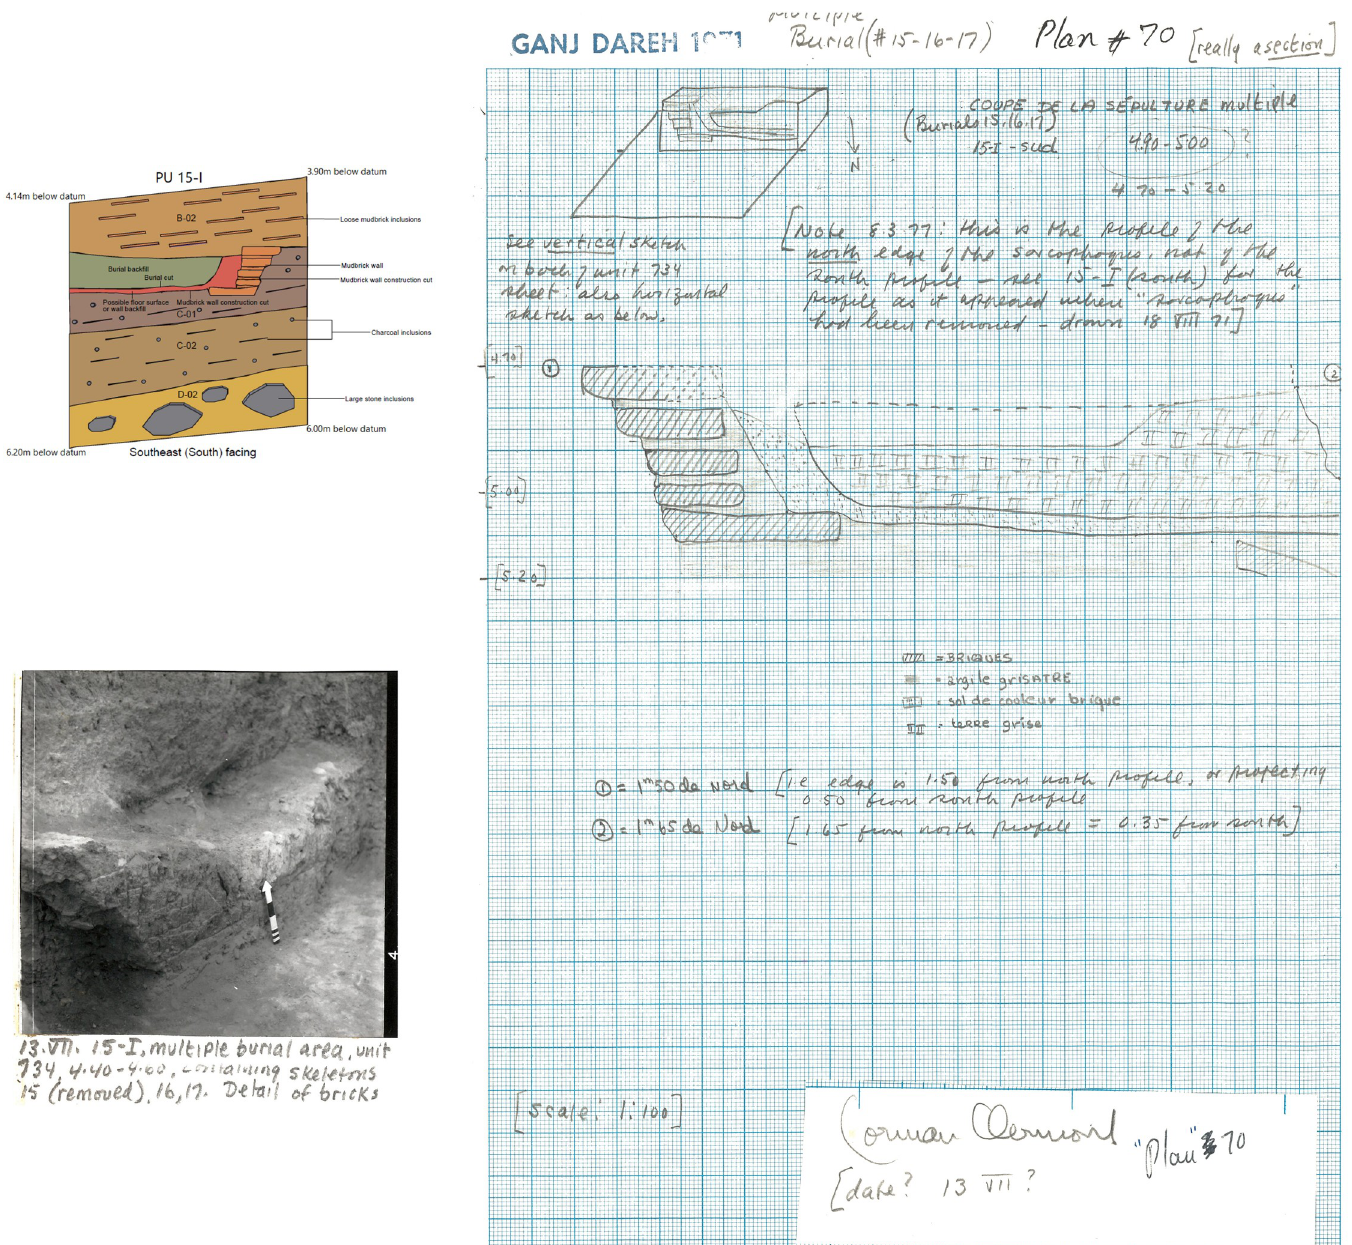
Fig 17. A. Level C-01 burial, composite section (viewed from the south). B. Field photograph of structure of the burial (looking from the north). C. Field notes detailing the